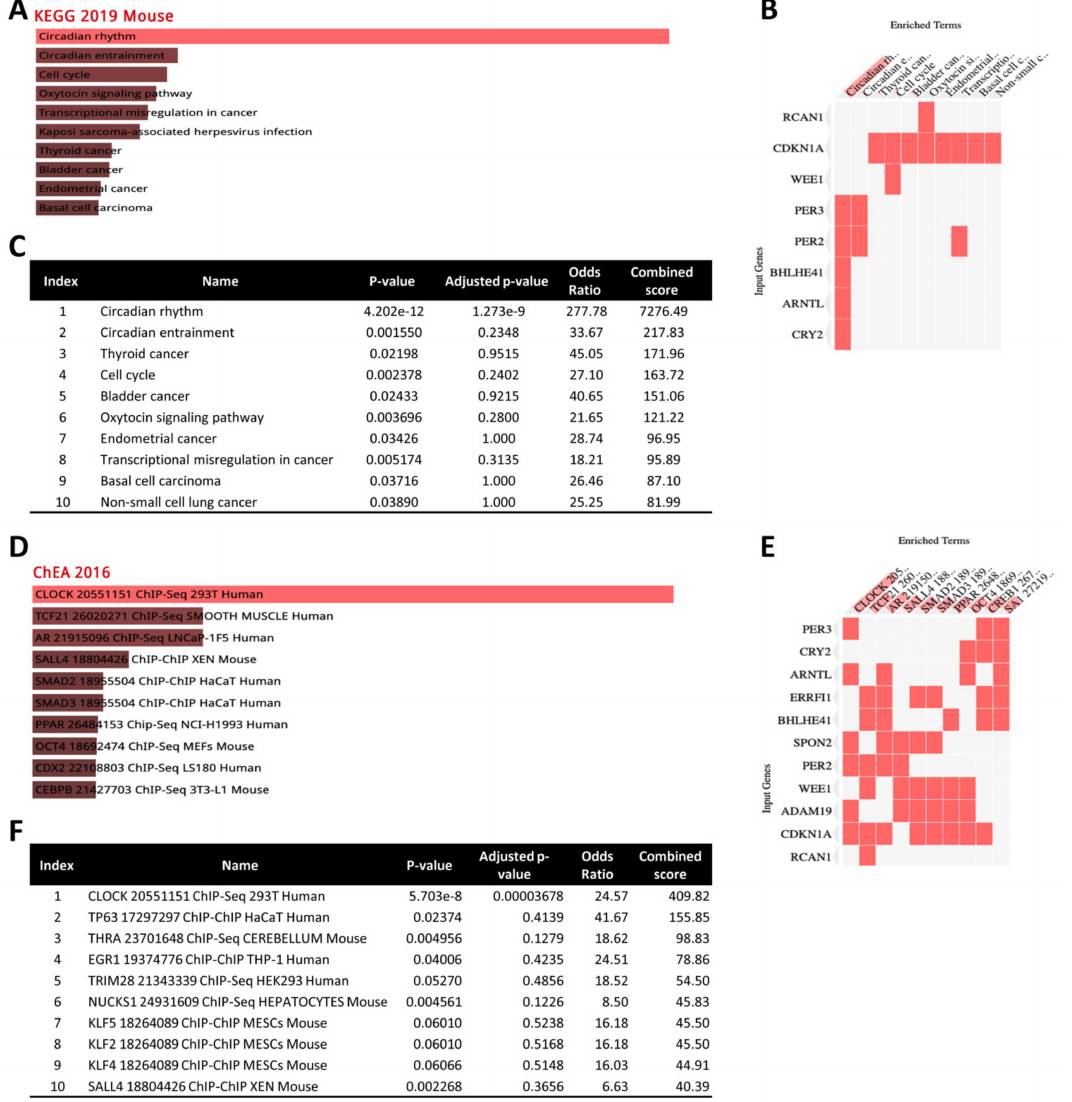
Figure 6. A comprehensive gene set enrichment analysis for the 12 common genes differentially regulated across all 3 radiation groups was performed using EnrichR and the Kyoto Encyclopedia of Genes and Genomes (KEGG) 2019 Mouse database and ChIP-X enrichment analysis (ChEA) gene set library. ( A ) Bar graphs (sorted by p -value ranking) represent